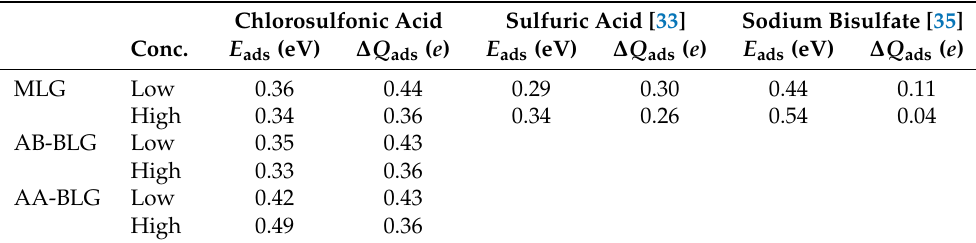
Table 2. Calculated adsorption energies ( E ads ) as well as electron transfers ( ∆ Q ads ) to each acid molecule for chlorosulfonic acid for two concentrations: low (one molecule per 32 carbon atoms in MLG) and high (one molecule per 18 carbon atoms in MLG). Values corresponding to sulfuric acid and sodium bisulfate are given for